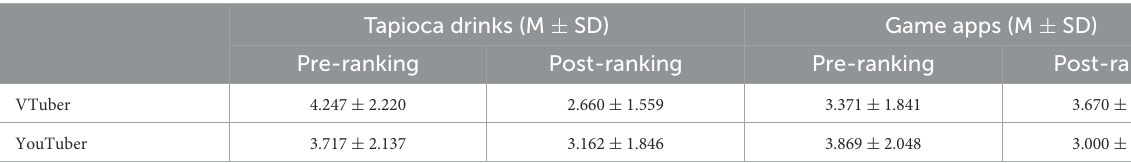
TABLE 1 Changes in rankings of the two product domains.